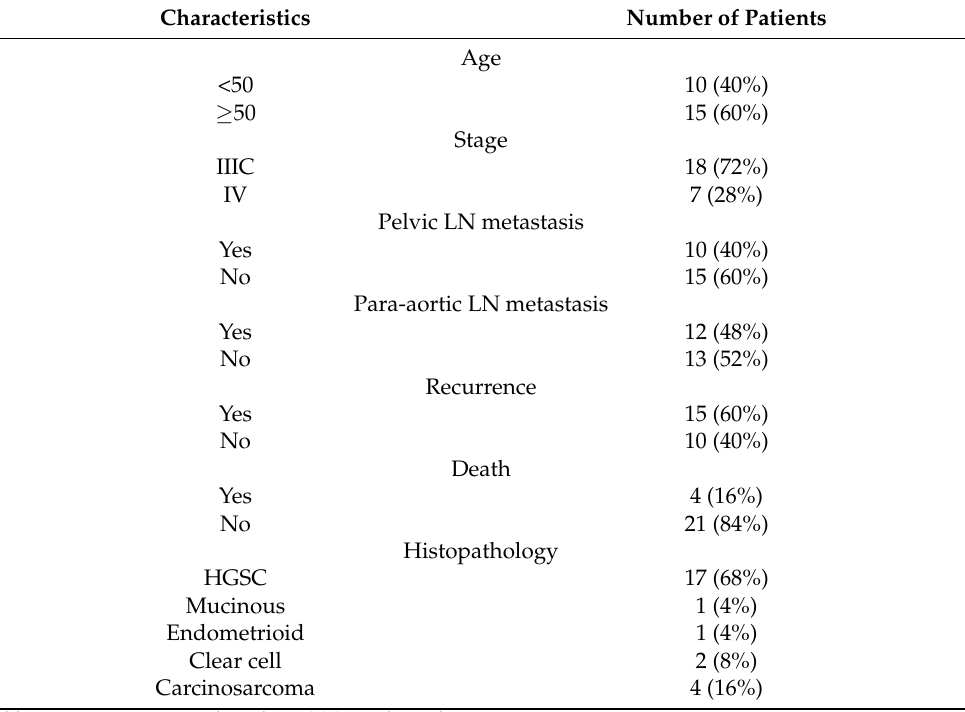
Table 1. Histopathology and characteristics of enrolled patients with ovarian malignancy ( n = 25). Characteristics Number of Patients Age